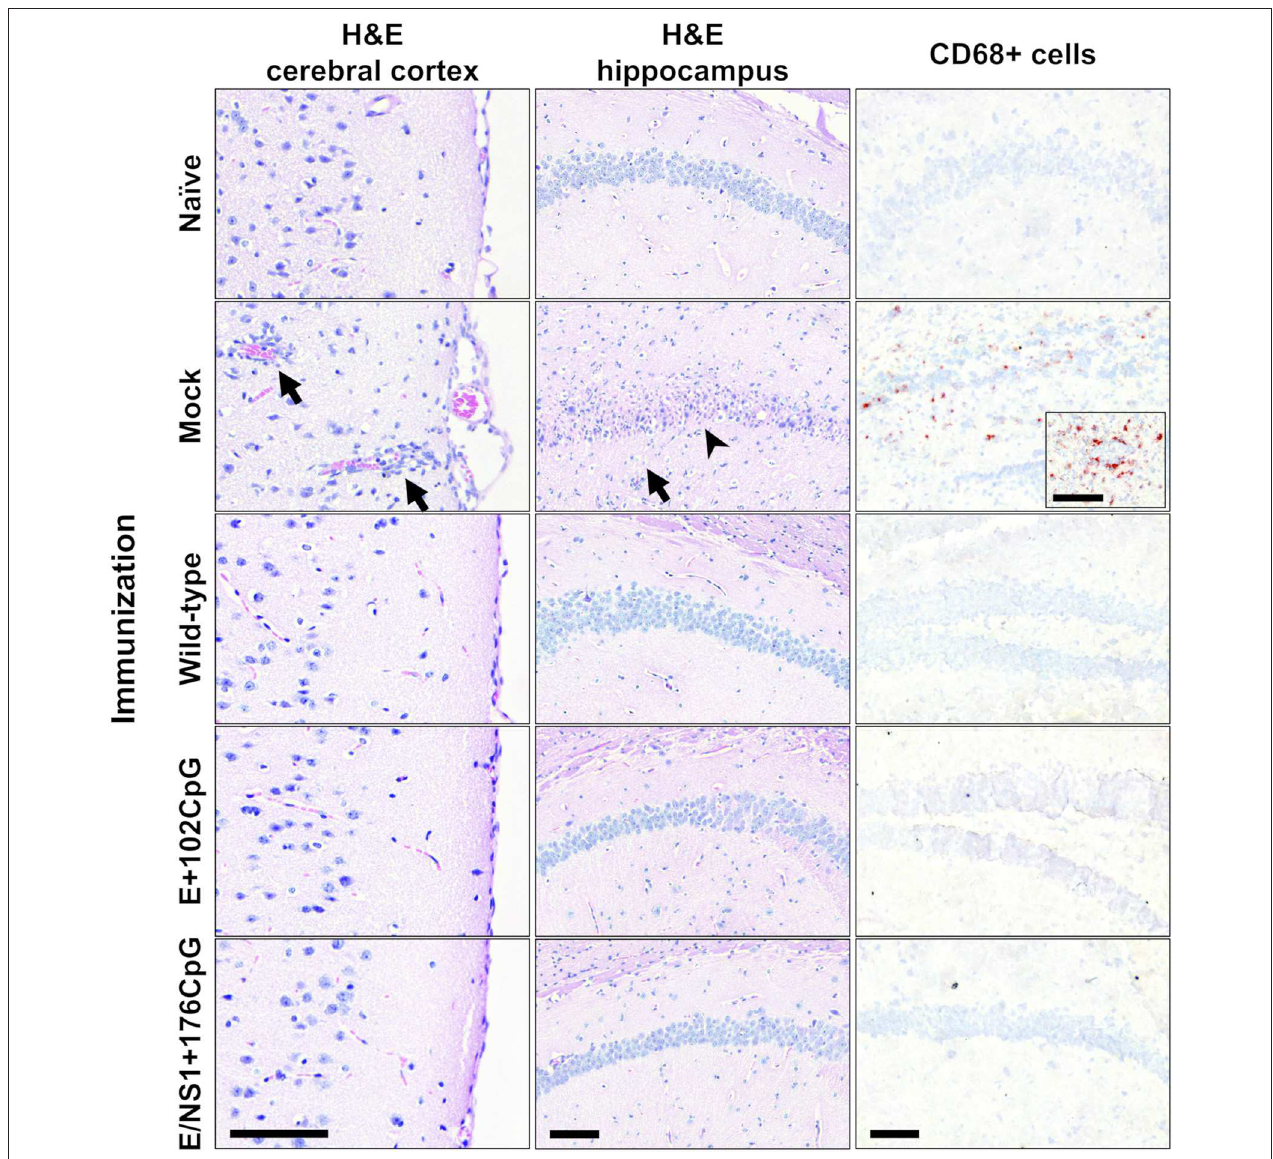
FIGURE 11 | Histopathology and immunohistochemistry in mouse brains. H&E: Cortical monocyte infiltration, inflamed cortical blood vessels (arrows), hippocampal monocyte invasion (arrow), and necrosis of hippocampal neurons (arrowhead) were detected only in mock-immunized mice. Immunohistochemistry: CD68-positive cells were detected in brains from only mock-immunized mice. Brains from all control and experimental animals ( Figure 10 ) were tested. Scale bars are 100 µ m.